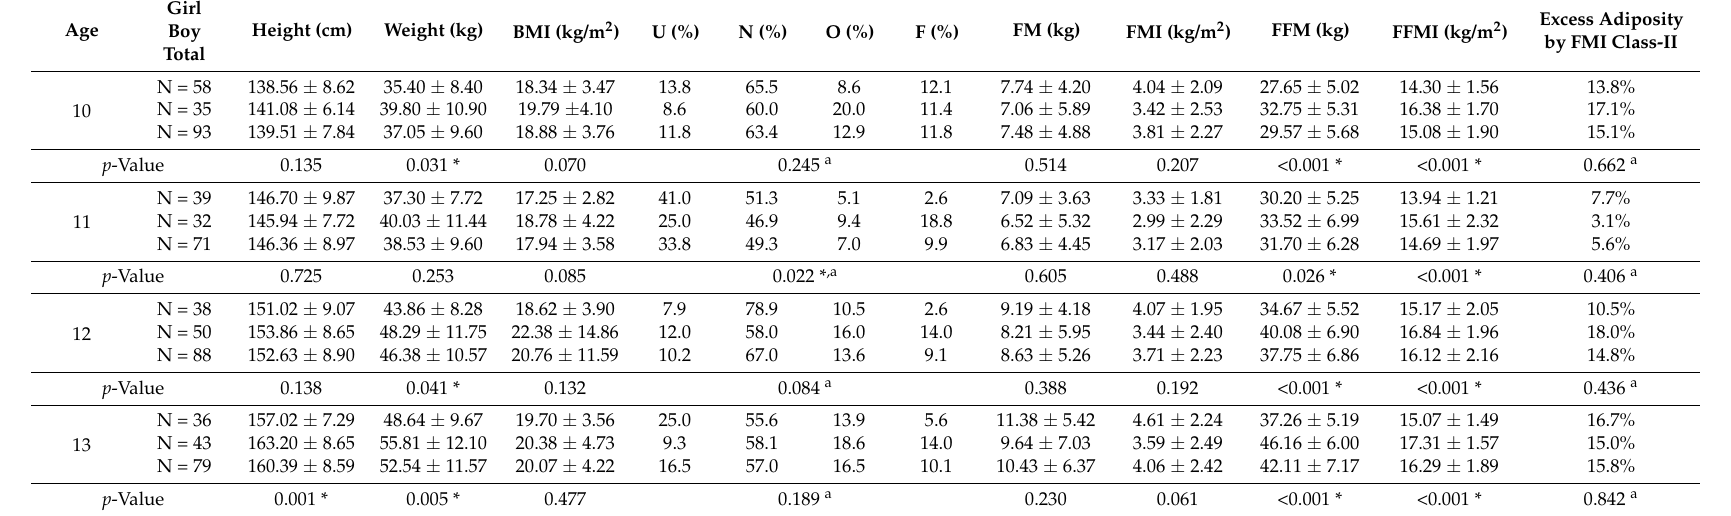
Table 2. Baseline characteristics of all subjects by age- and sex-specific